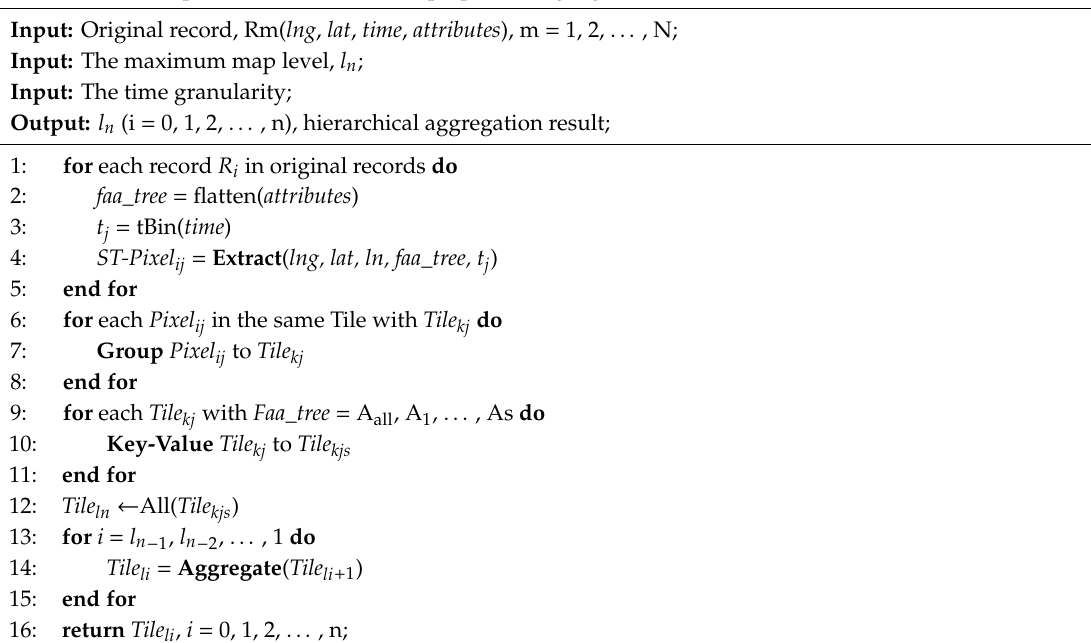
Algorithm 1 The pseudocode of the MAP preprocessing algorithm